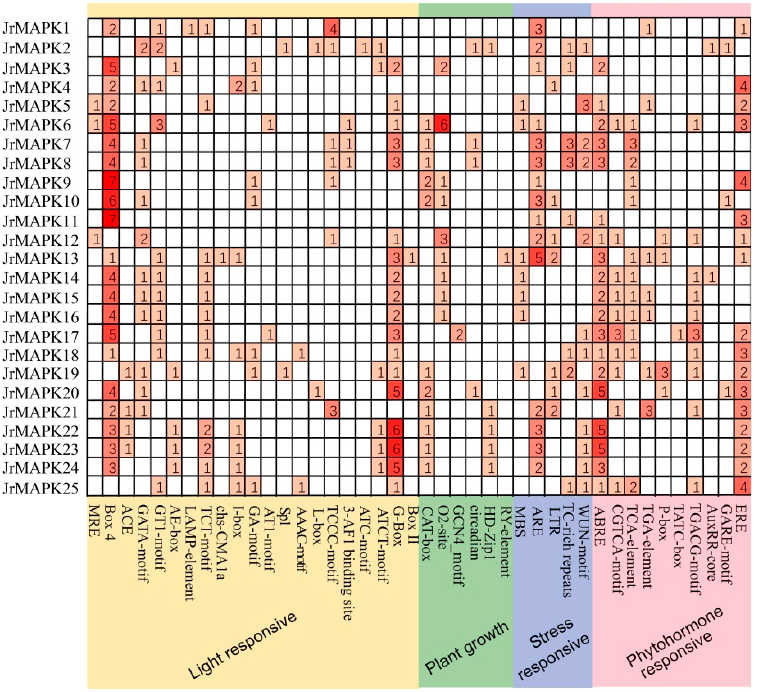
Figure 6. Distribution of the cis-acting elements in the promoters of the JrMAPK